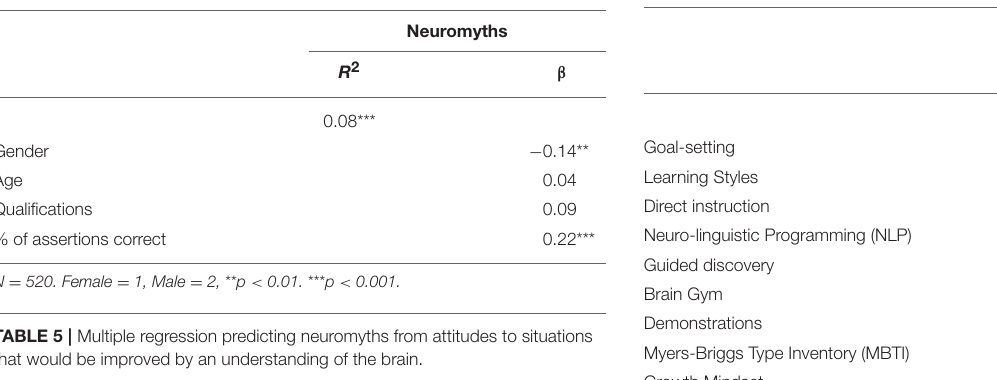
TABLE 4 | Multiple regression predicting neuromyths from demographics and general assertions.